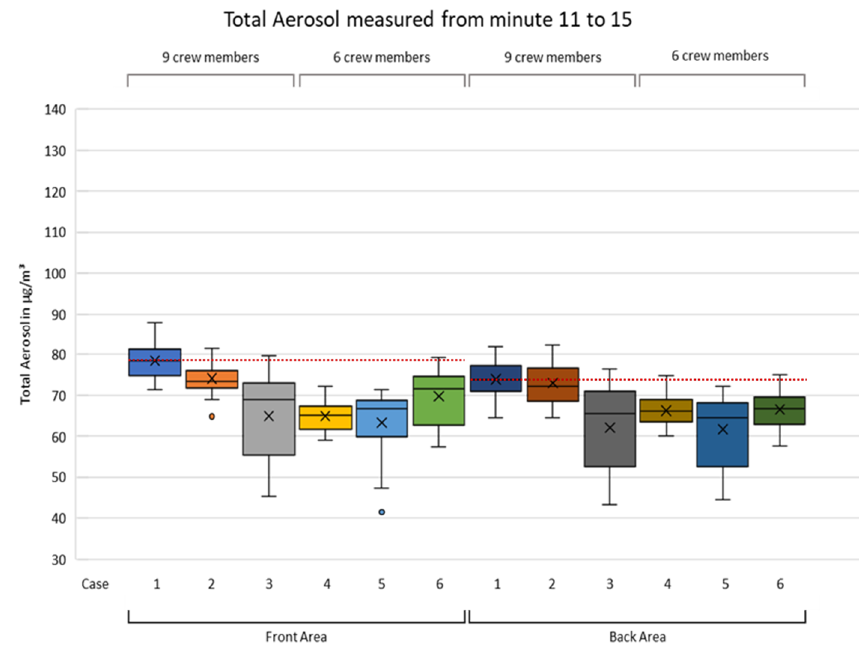
Figure A1. Total aerosol burden measured from minute 6 to 10.